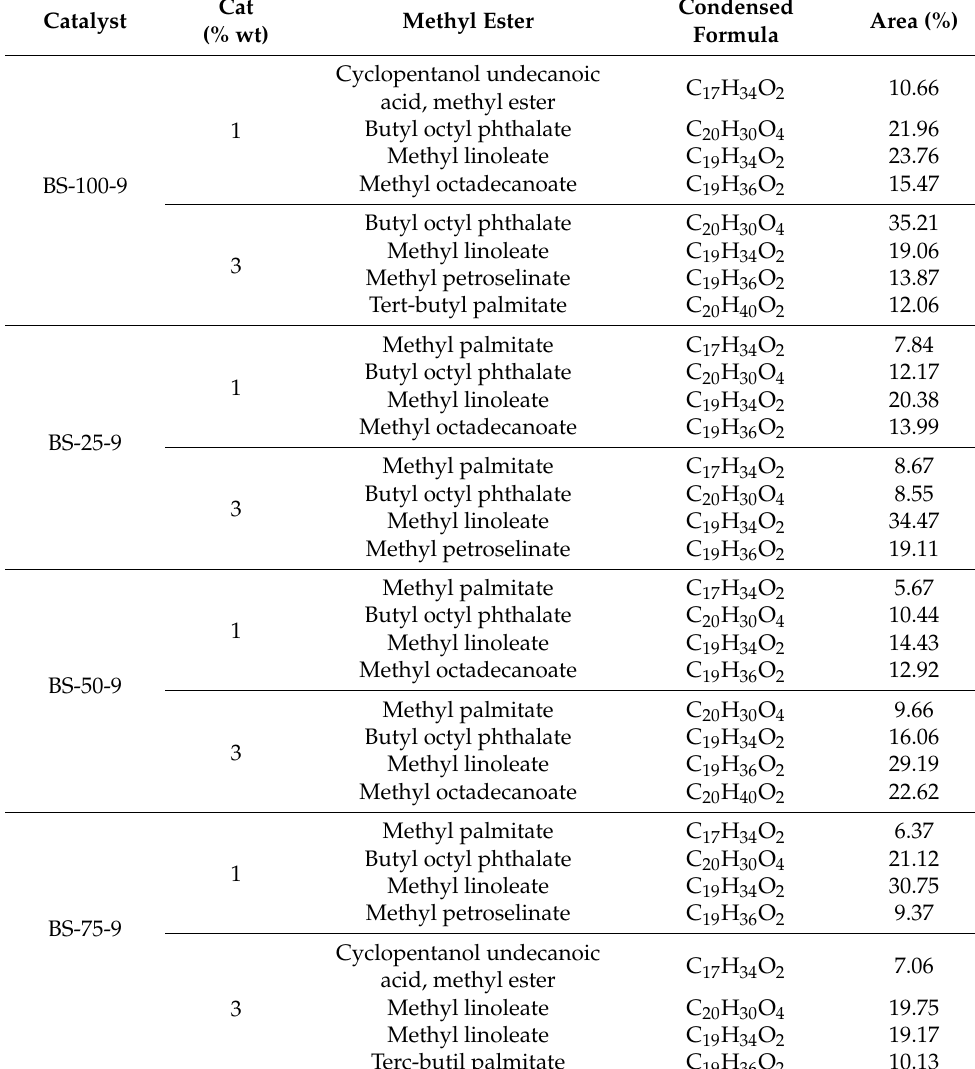
Table 6. GC–MS analysis of the biodiesel produced using the catalysts BS-100-9, BS-25-9, BS-50-9 and BS-75-9 at 1 and 3